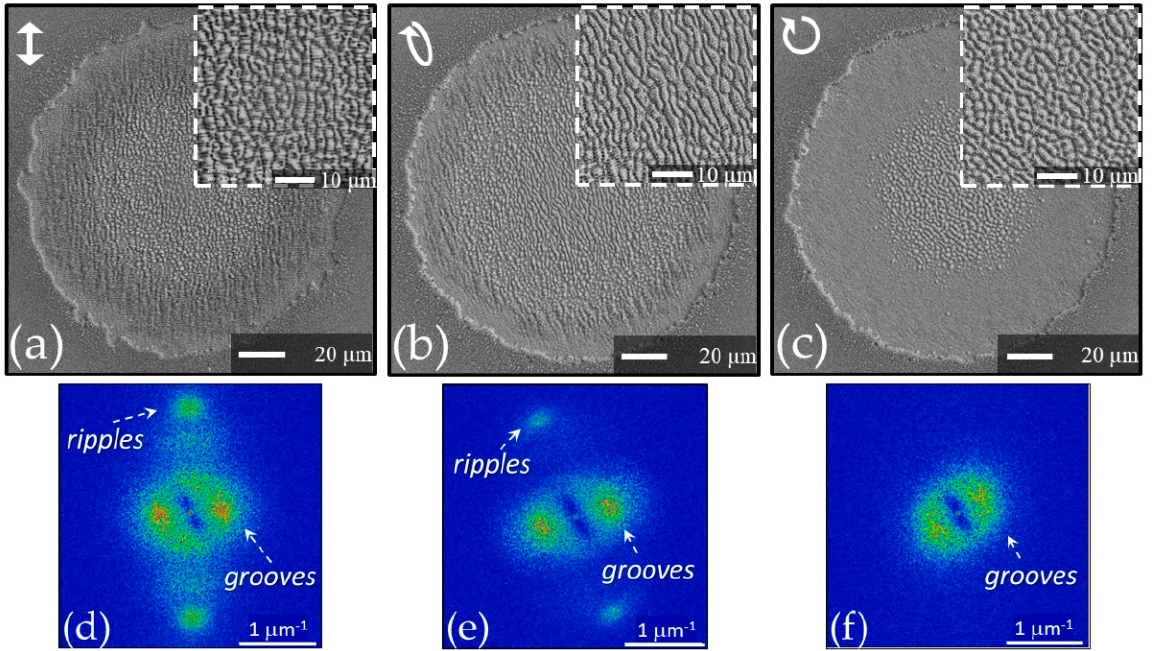
Figure 7. SEM images of the craters produced with a Gaussian beam at wavelength of 1055 nm and pulse duration of ≈ 900 fs for three different states of polarization: ( a ) linear, ( b ) elliptical, and ( c ) circular. In each condition, the surface is irradiated with N = 200 laser pulses at an energy of E ≈ 150 µ J. In each panel ( a – c ), the upper-right inset shows a zoomed view of the central region of the SEM image. Panels ( d – f ) report the 2D-FFT maps obtained from the corresponding upper panels ( a – c ). The graph in the upper-left corner of panels ( a – c ) represents the beam polarization.